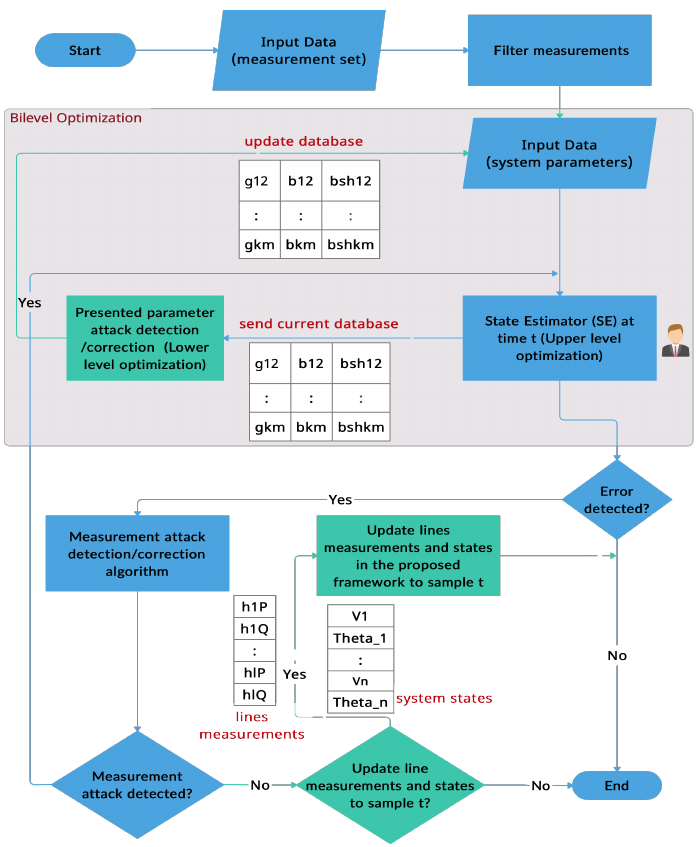
Figure 1. Flowchart of the inclusion of the proposed